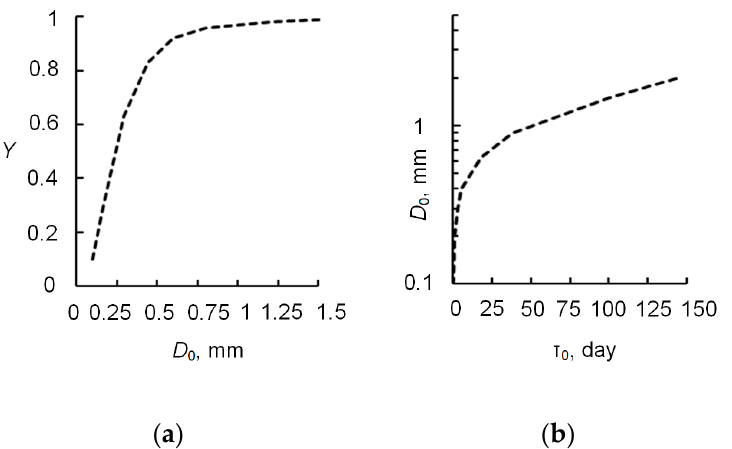
Figure 3. ( a ) The conversion rate dependence of the methane hydrate on the particle diameter D 0 ( T = 268 K, pore diameter d p = 0.2 µm, dissociation time for all the diameters is 14,400 s); ( b ) The dependence of the total dissociation time ( τ 0 ) of the methane hydrate on diameter D 0 ( T = 268 K, pore diameter d p = 0.2 µm) [67].